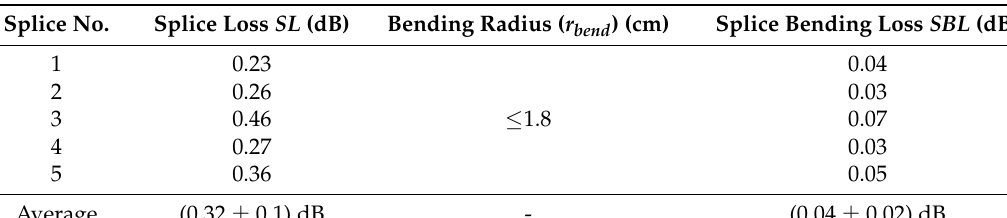
Table 1. Splice loss, bending loss and bending radius of five consecutive HCPBF-MMF splices, fabricated with optimal splicing parameters presented in Table A1. The last row contains the average values of the presented results, together with their standard deviation.